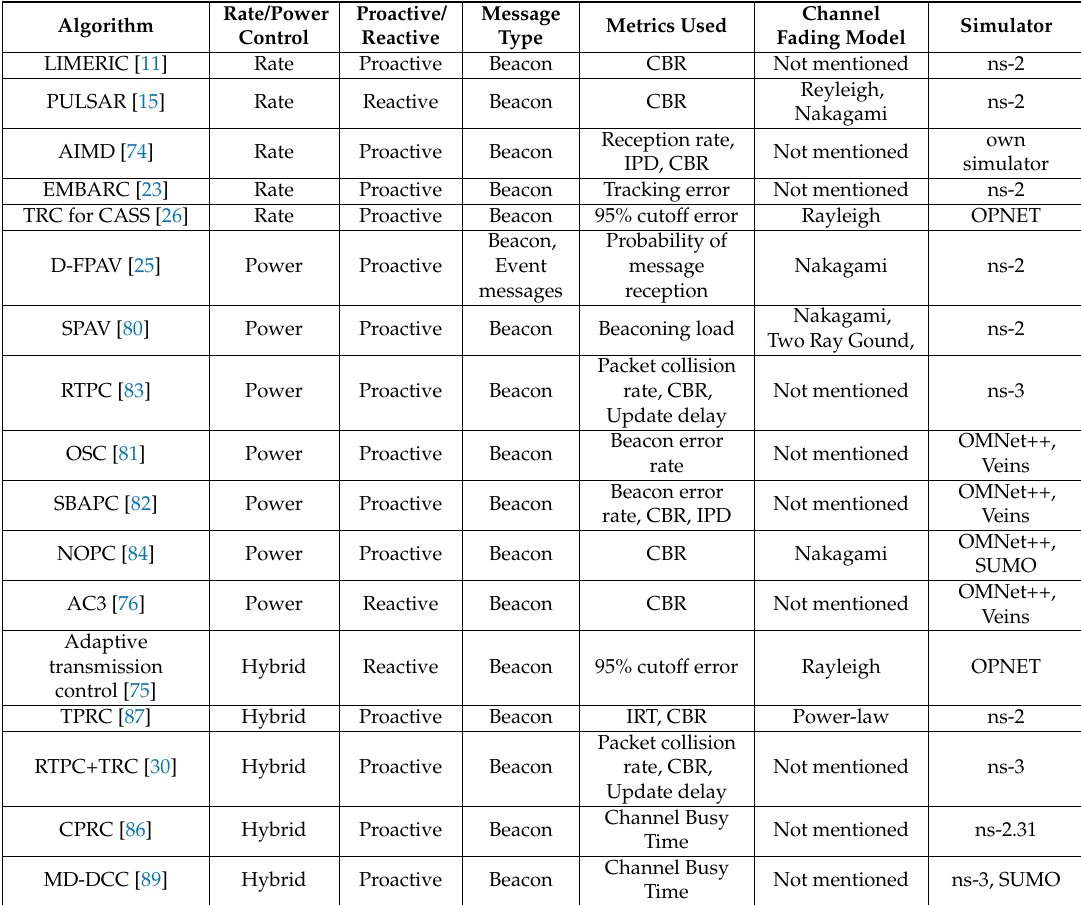
Table 1. Classification of congestion control